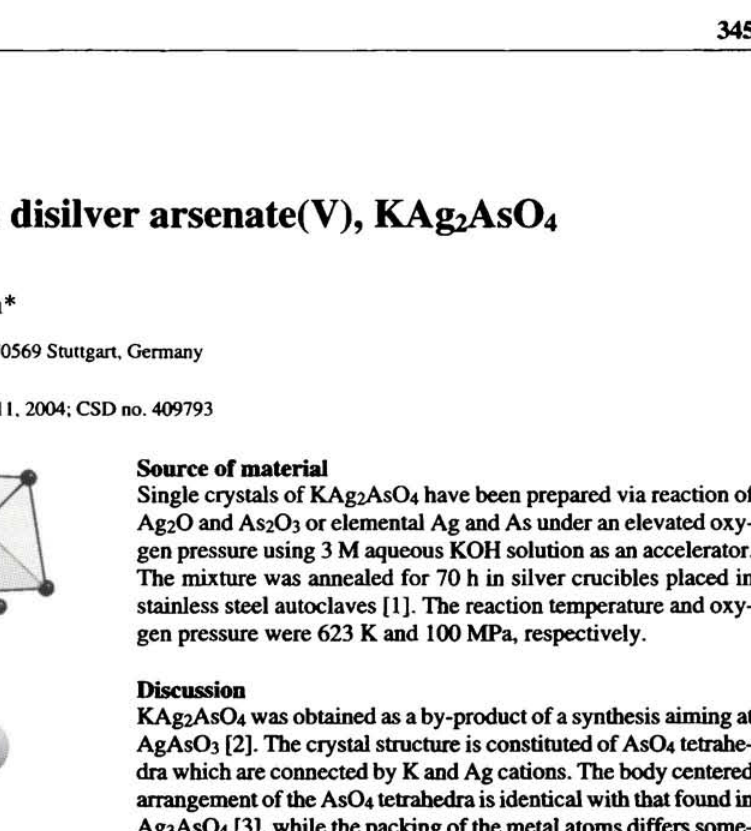
Table 1. Data collection and handling. Crystal: Wavelength: H- Diffractoraeter, scan mode: